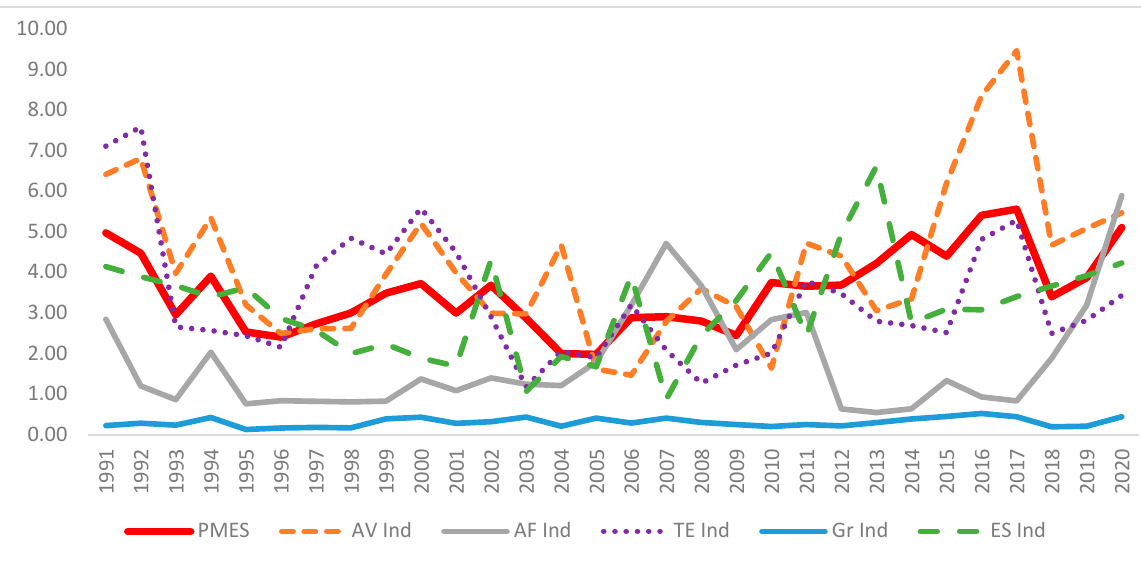
Figure 3. Indices across dimensions and PMESI.